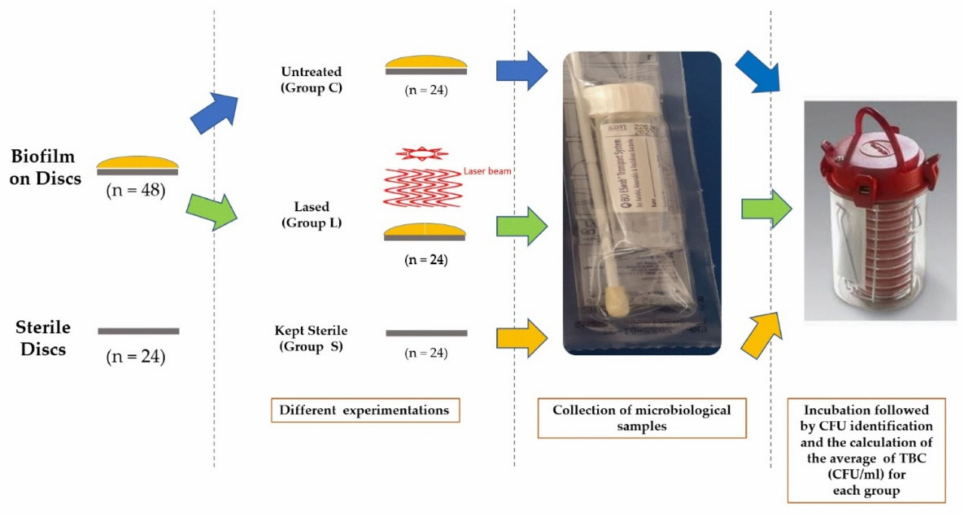
Figure 4. Schematic representation of the different steps and groups of the